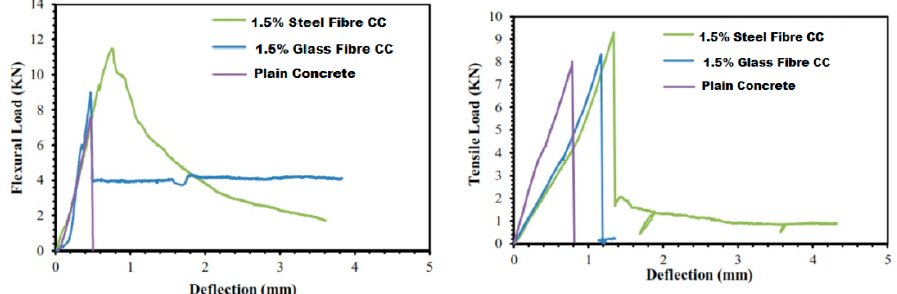
Figure 2. Failure type based on the quantity of fibers [28].